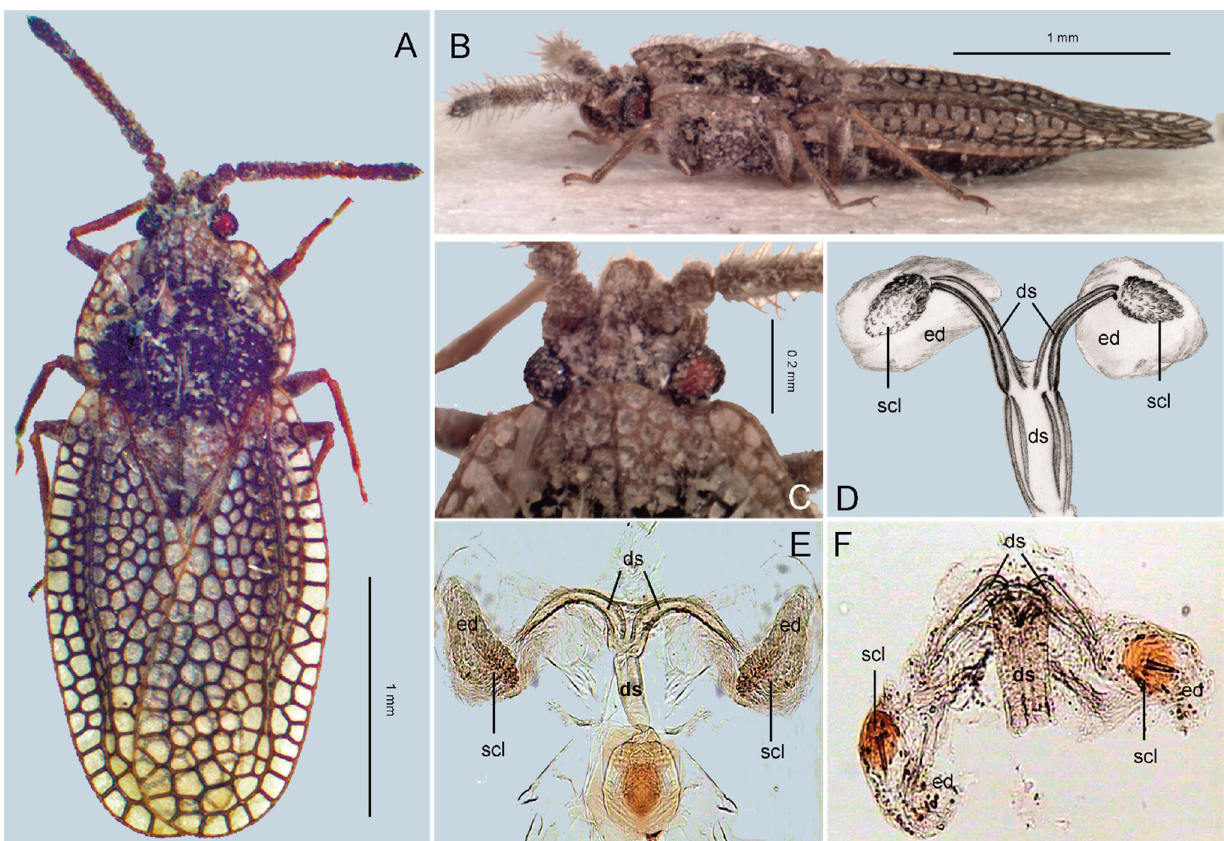
Figure 1. ( A – C ) One of two specimens of Recaredus rex sampled during the Czechoslovak–Iranian entomological expedition to Iran in 1977. ( A ) Habitus, dorsal view. ( B ) Habitus, lateral view. ( C ) Head, dorsal view. ( D – F ) . Ductus seminis (ds), endosomal diverticula (ed) and endosomal sclerites (scl). ( D ) Recaredus rex (after [7], modified). ( E ) Derephysia foliacea (Fallén, 1807). ( F ) Kalama tricornis (Schrank, 1801) (after [33], modified).